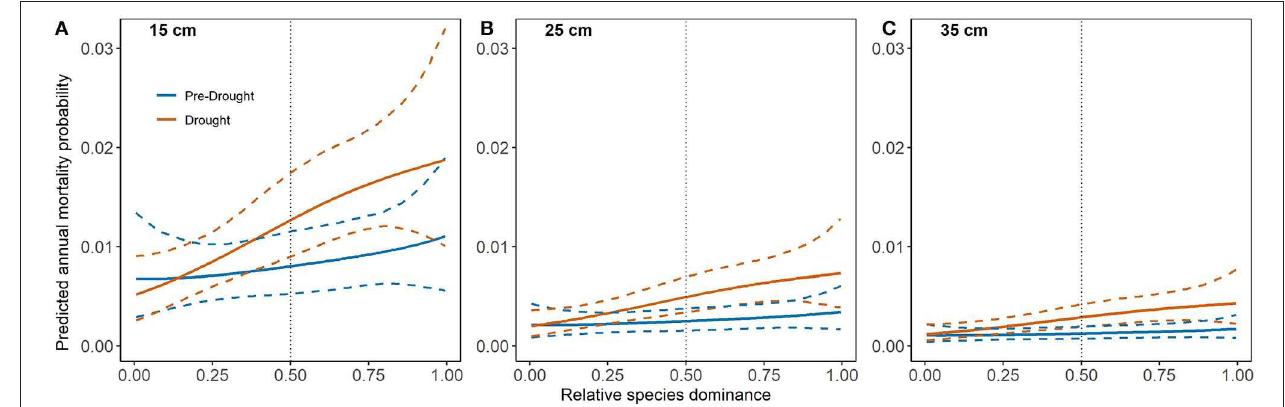
FIGURE 5 | Mortality curves (solid lines) for naturally-regenerated loblolly pine (NL) and species dominance (SPD) with 95% credible intervals (dashed lines). Diameter at breast height (DBH) is held constant at merchantable size classes, (A) 15, (B) 25, and (C) 35cm, while relative density (RD) is held constant at the lower limit of fully-stocked conditions (35%). Pre-drought period trees were measured and re-measured from 2003 to 2010 while drought period trees were initially measured prior to 2011 and re-measured 2012–2016. Dotted vertical lines highlight 50% dominance by naturally-regenerated loblolly pine